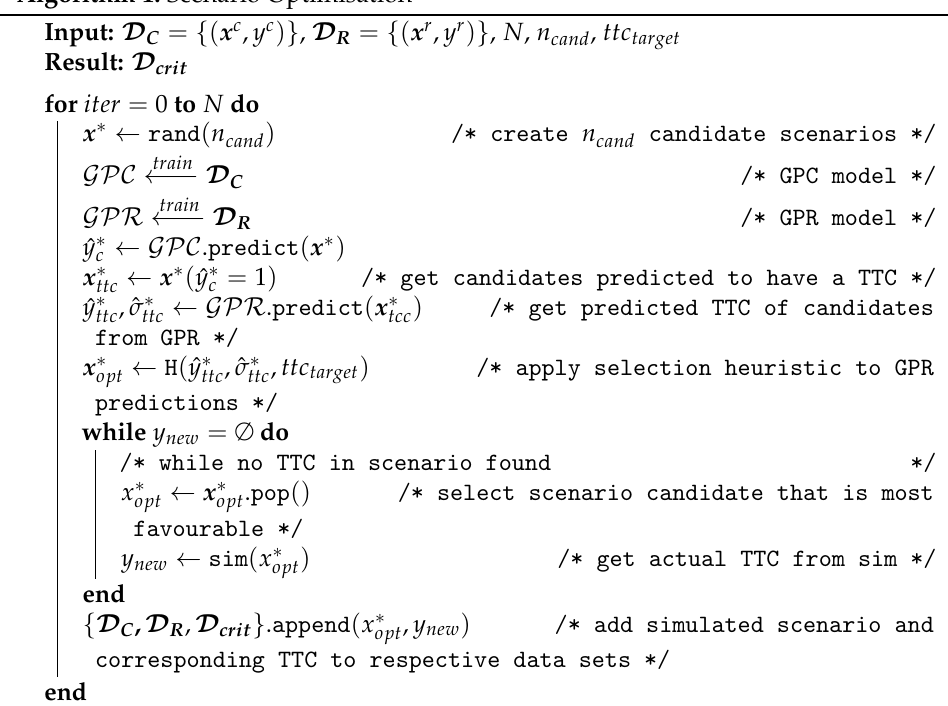
Algorithm 1: Scenario